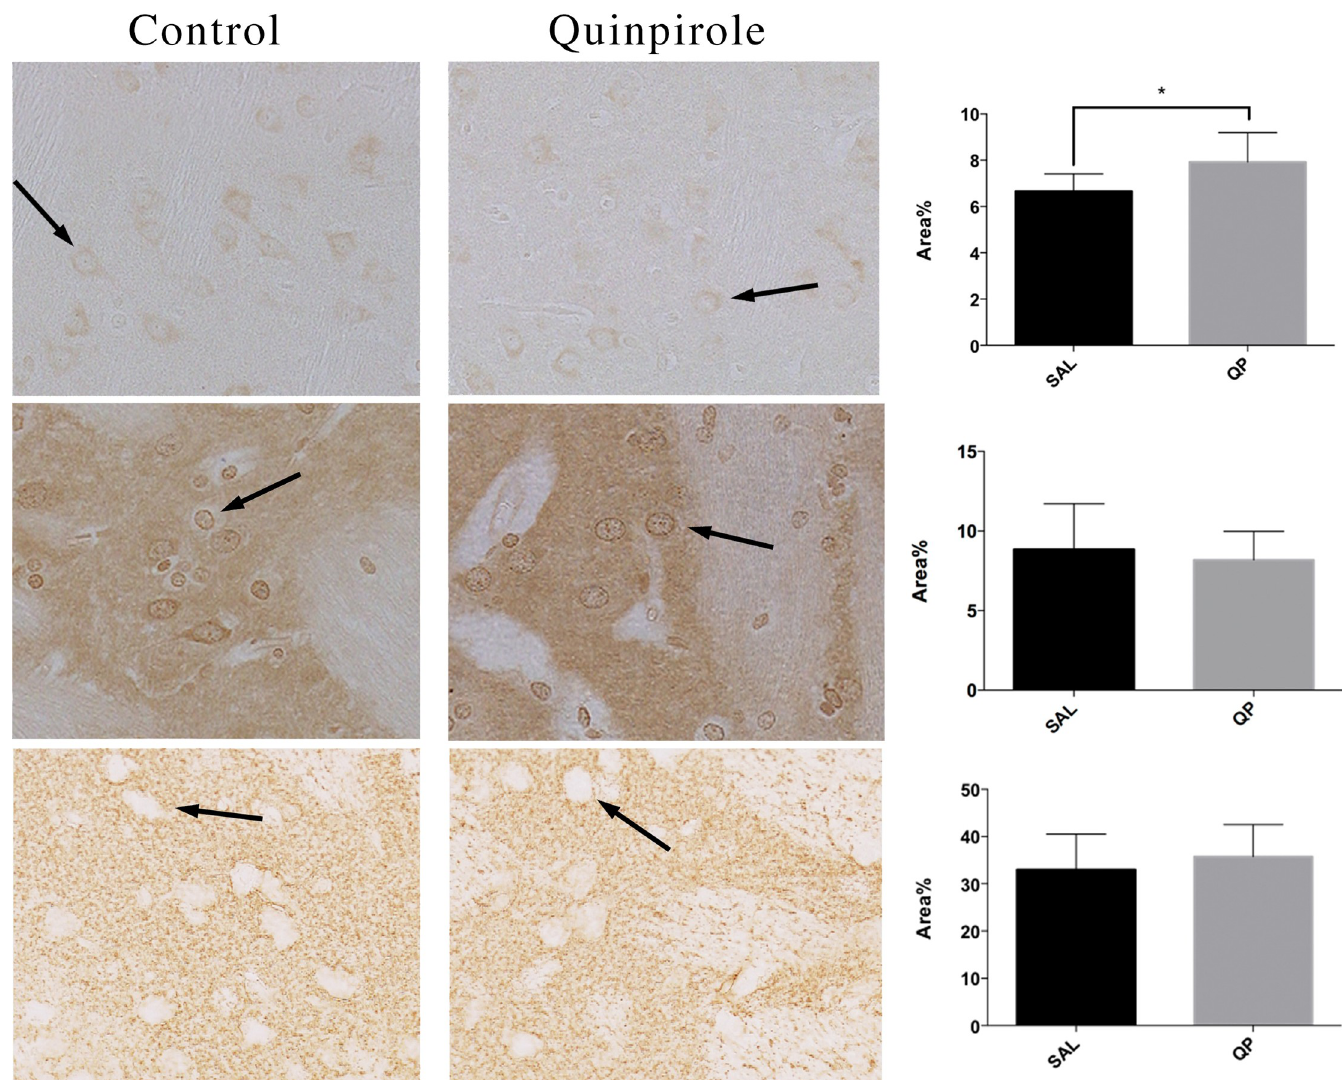
Fig 3. Immunohistochemistry. Image (20x) of the caudate putamen of an animal that was exposed to either chronic quinpirole (QP) or functioned as a control (SAL) after staining with either the D2R antibody (top), the mGluR5 antibody (middle) or the GLT-1 antibody (bottom). As GLT-1 is present on the astrocyte, the staining will occupy the space between neuronal cells. These neuronal cells will therefore remain uncoloured. For visual representation, one exemplary neuron is marked in each staining with an arrow. In the right utmost column, the area percentage expressed as percentage of pixels in the image that have been highlighted by the staining after either QP (n = 7) or SAL (n = 7). Individual points, median and standard deviation of each group are displayed. � p <